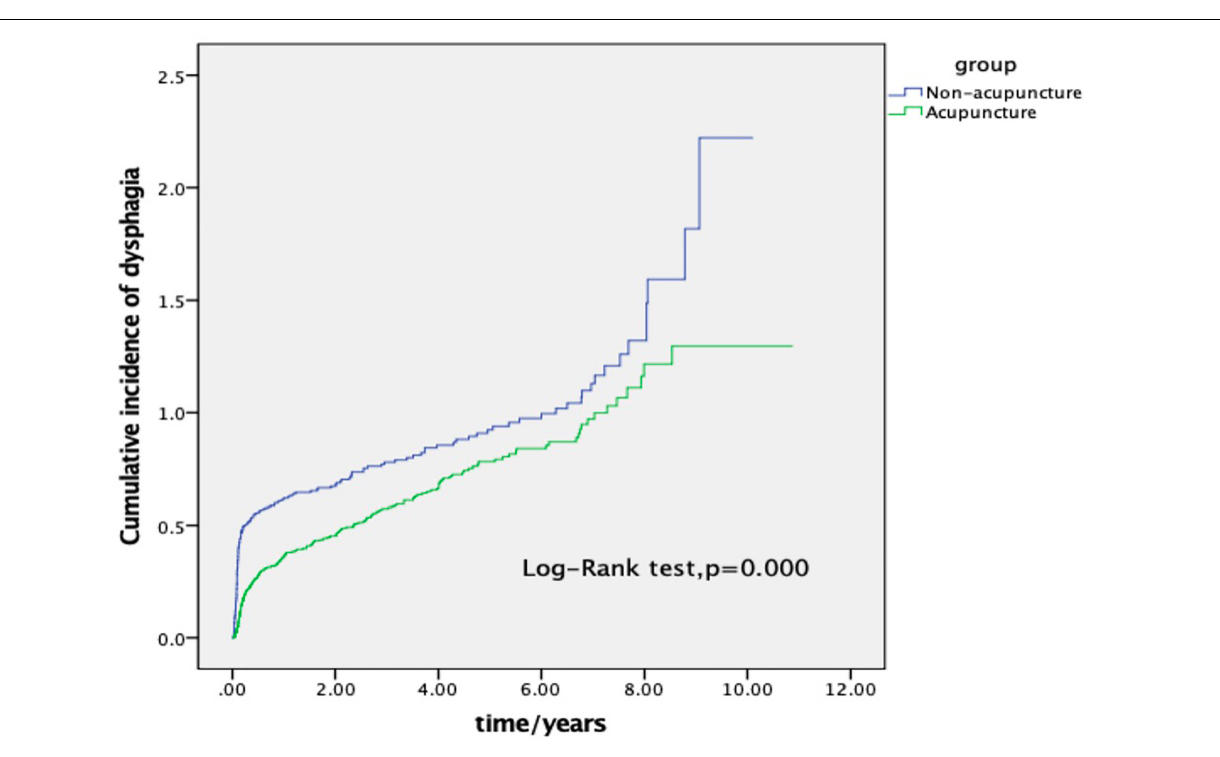
(CHR = 4.29, P = 0.012; AHR = 3.39, P = 0.035). Stroke with multiple lesions indicates that the severity of stroke is